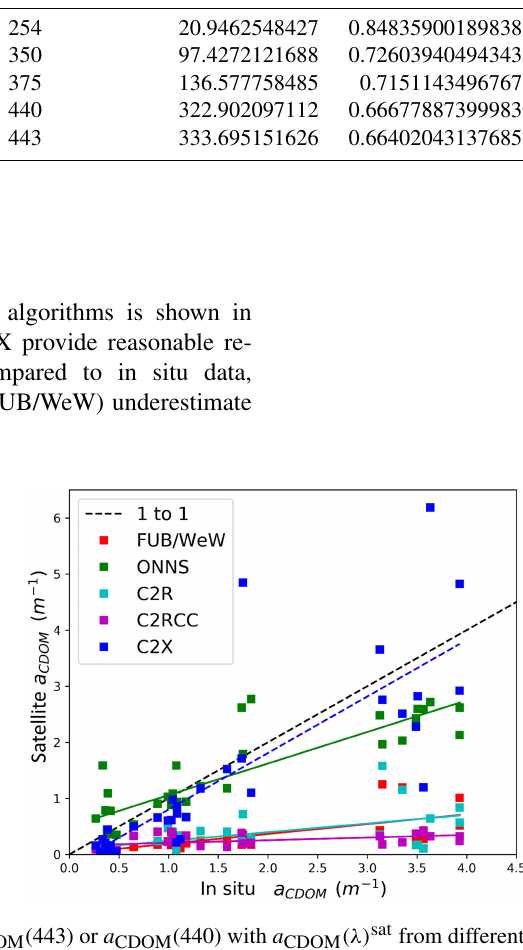
Figure B1. Comparison of in situ a CDOM (443) or a CDOM (440) with a CDOM (λ) sat from different OCRS